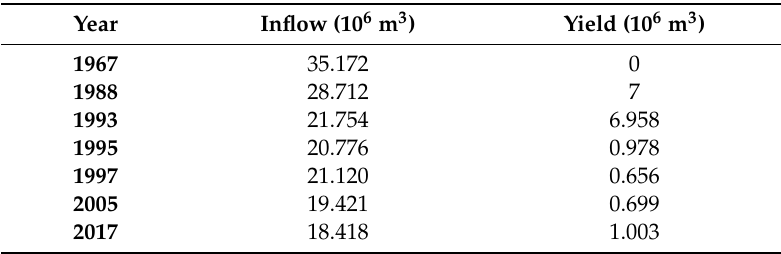
Table 5. Bathymetric surveys and solid inflow data in the